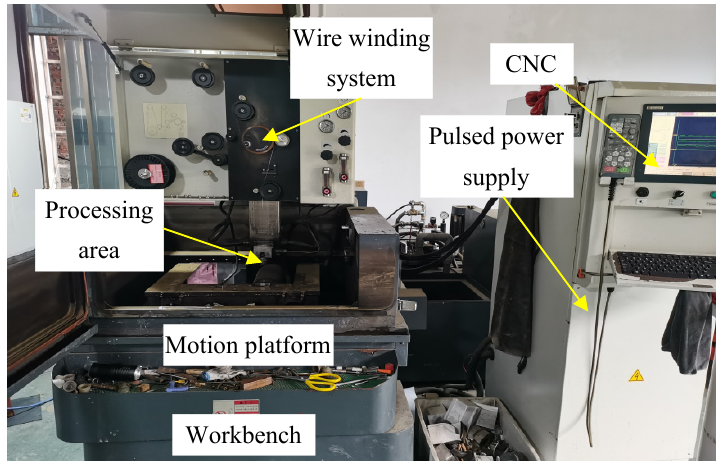
Figure 1. ACCUTEX EZ-43 SA machine tool.